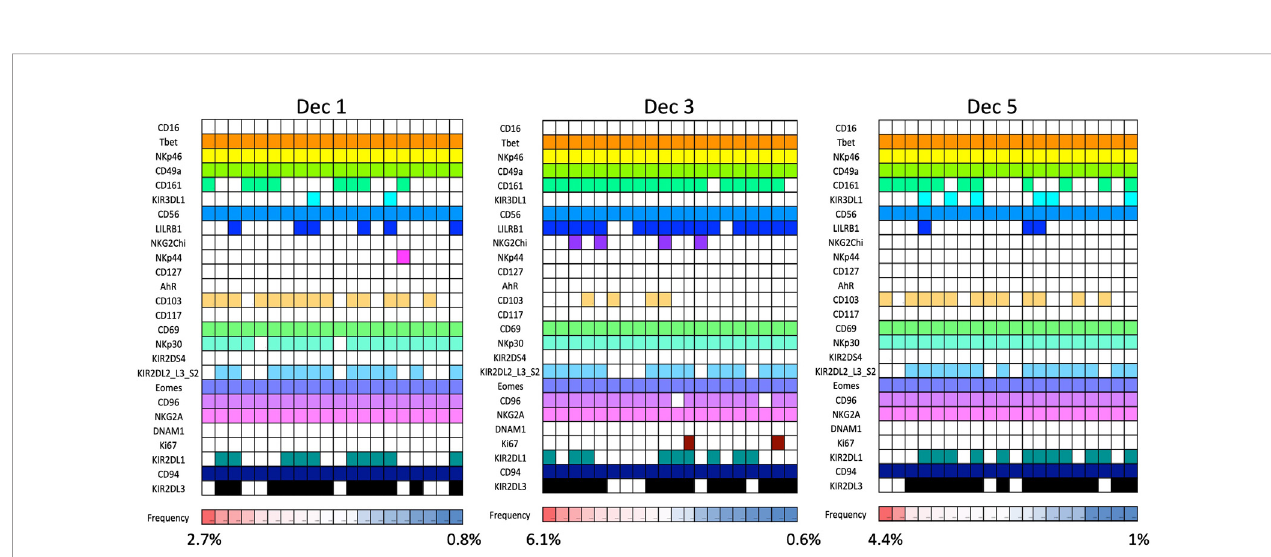
FIGURE 6 | dNK receptor repertoire diversity Frequencies of the most common NK cell phenotypes were determined by mass spectrometry in freshly isolated CD45+Lin − CD56+ decidual NK cells for three selected individuals based on combinations of 26 individual phenotypic markers expressed on each cell. The twenty most frequent phenotypes detected are shown for each donor Dec1,3,5. Each column represents a phenotype shared by a number of cells; boxes are coloured if the marker is expressed in that phenotype. Frequencies of each phenotype as a percentage of total CD45+Lin − CD56+ are displayed as a heat map at the bottom of the fi gure. Based on analysis of data from Huhn et al.